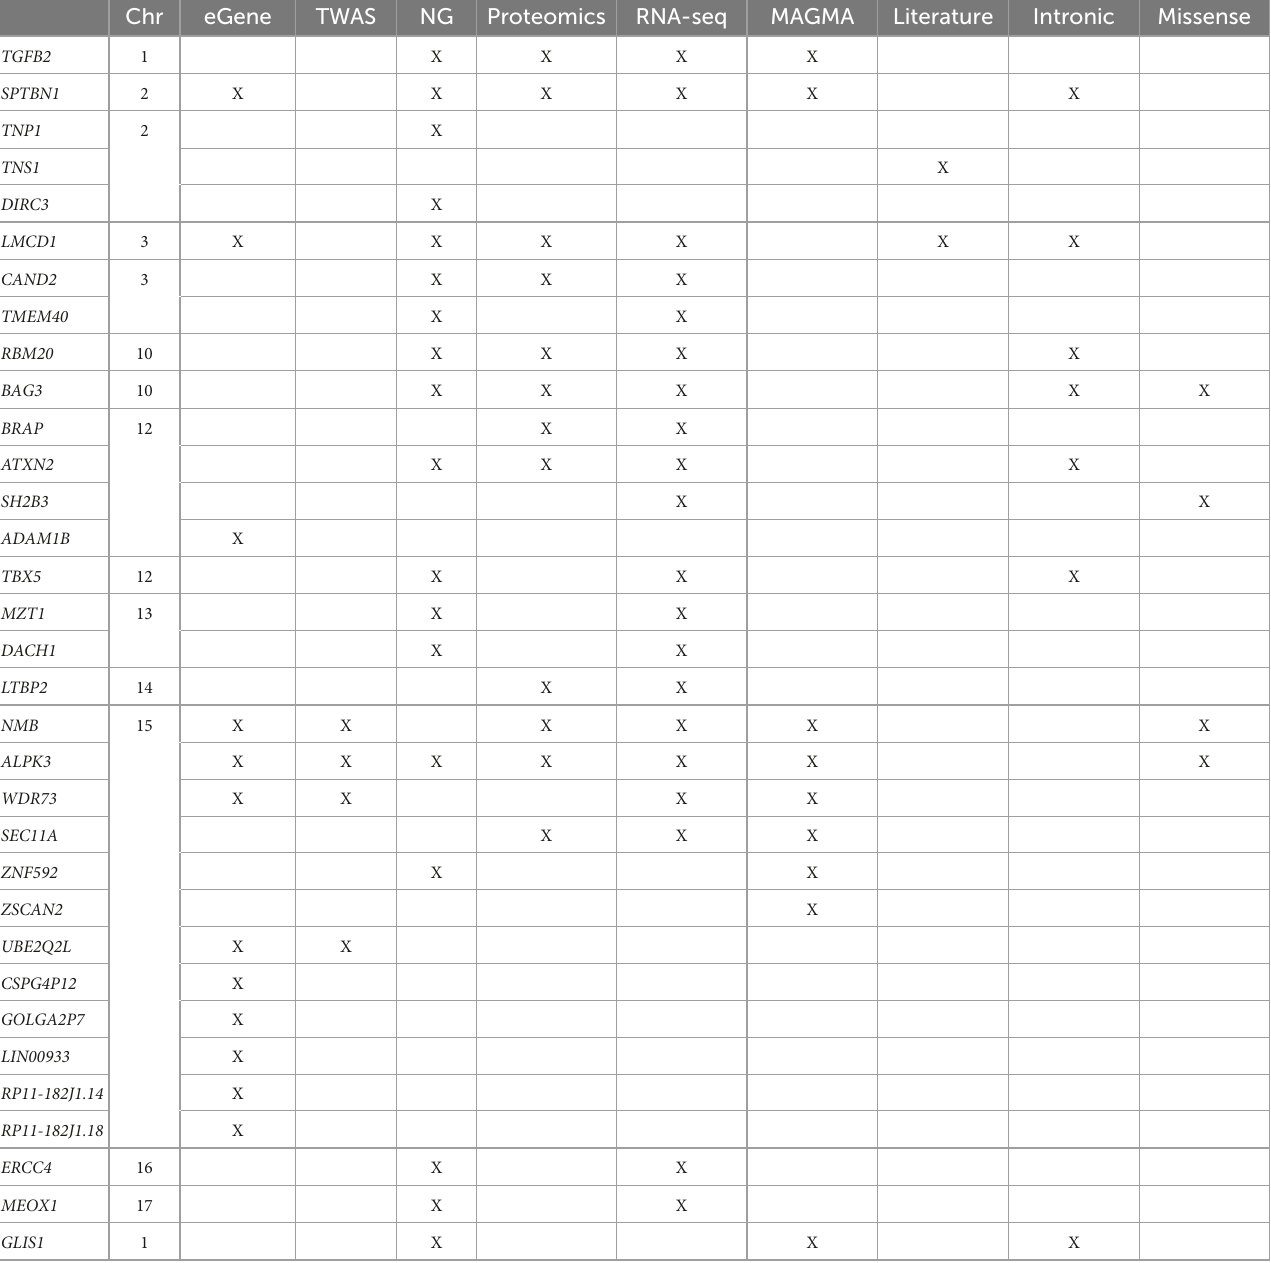
eGene, expression quantitative trait locus gene; GWAS, genome-wide association study; MAGMA, multi-marker analysis of genomic annotation; MVP, mitral valve prolapse; NG, nearest gene(s); RNA-Seq, RNA sequencing; TWAS, transcriptome-wide association study. Each line corresponds to a candidate gene. Each column presents the lines of evidence for each gene. Cross indicate that